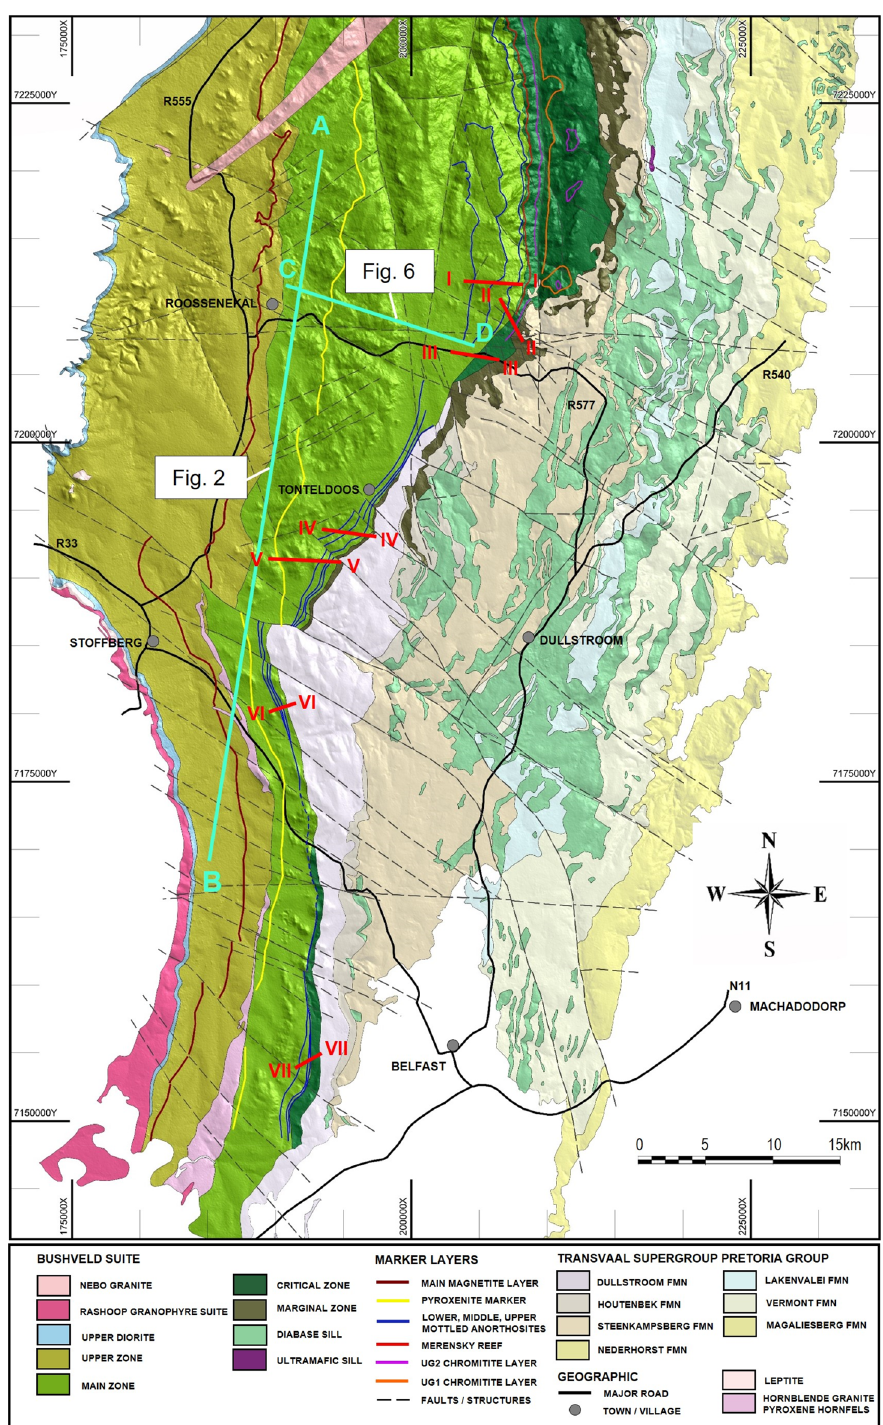
Figure 1. The geological map of the southeastern part of the Bushveld Complex in the Tonteldoos area. The complex transgresses upwards through the Transvaal Supergroup over the northern 35 km of this sector and the floor of the complex steps up by approximately 6 km. The basal part of the Main Zone has three continuous markers layers termed the Lower, Middle, and Upper Mottled Anorthosites that extend along the entire area. The position of cross-sections in Figs. 2 and 6 and seven major traverses across Anorthosite Markers in Figs. 3, 4, 5 (see also Supplementary Data) are indicated. Regional geology digitised from the 1:250,000 scale geology maps 2528 Pretoria and 2530 Barberton (Geological Survey of South Africa), with additional detail from mapping by Van der Merwe 49 , Bevington and Hornsey (2010, Nuplats Ltd, unpublished mapping), and Latypov and Chistyakova (2021, unpublished mapping). The figure was prepared by Richard Hornsey using Micromine 2021 Release